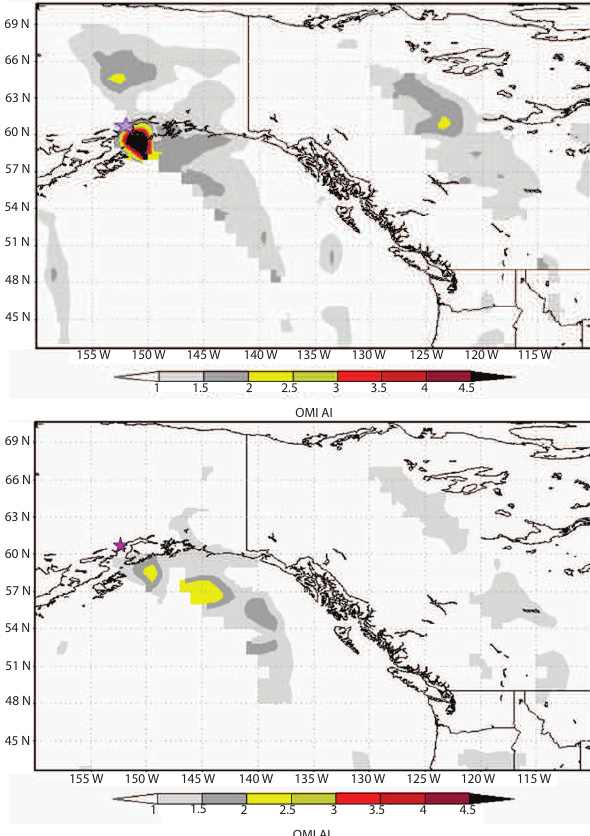
Fig. 3. OMI AI for (a) 26 March and (b) 4 April. The location of Mt. Redoubt is marked by a